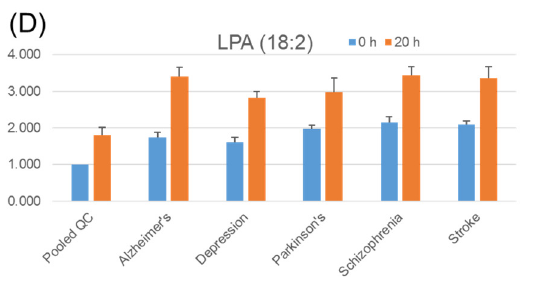
Figure 7. Stability of endogenous eicosanoids and LPA in serum. Pooled quality control (QC) serum samples and pooled disease serum samples were incubated at 37 ◦ C for 20 h. Three replicates of each pooled serum sample were tested. Extraction, tandem mass tag (TMT) derivatization, and LC/MS analysis were performed as described in the Methods section. The Y -axis shows the values relative to those of pooled QC serum with no incubation (0 h) for each lipid. Error bars represent the standard error of the mean (SEM). HETE, hydroxyeicosatetraenoic acid; TXB2, thromboxane B2, LPA, lysophosphatidic acid. ( A ) 12-HETE, ( B ) mixture of 20-HETE/18-HETE/15-HETE, or one of them, ( C ) TXB 2 , ( D ) LPA (18:2).